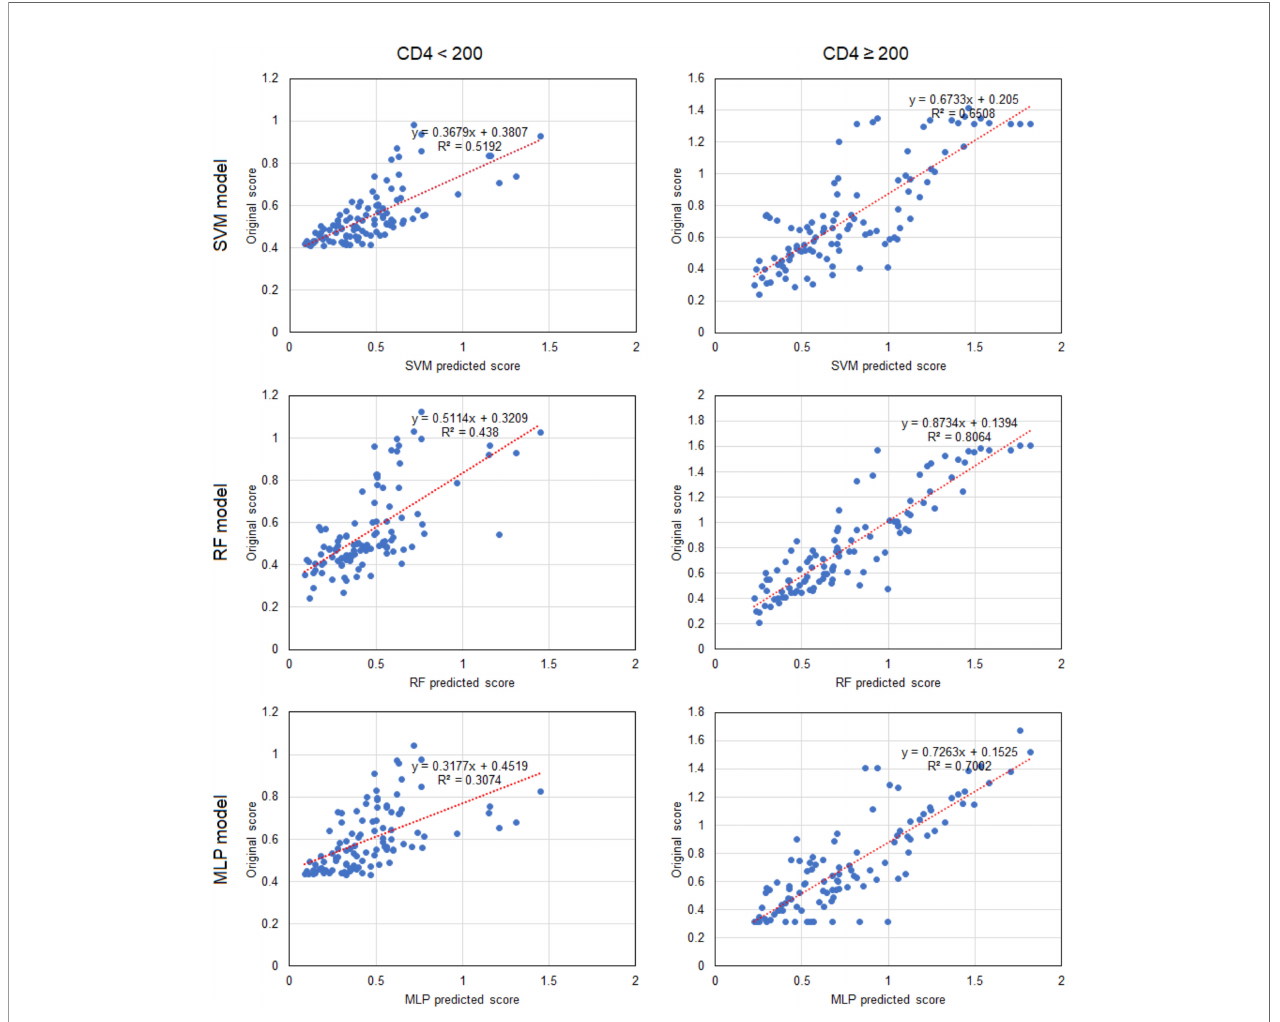
FIGURE 3 | Linear correlations of predicted scores and patient data for CD4/CD8 ratio in the three machine learning models. Each point represents a sample. CD4, CD4 + T cell; SVM, support vector machine; RF, random forest; MLP, multi-layer